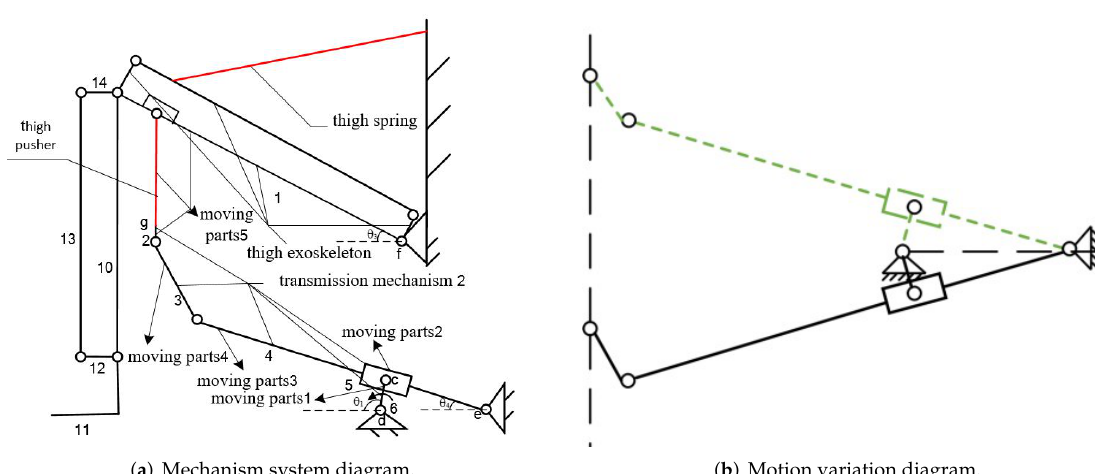
Figure 5. Hip joint rehabilitation transmission mechanism.